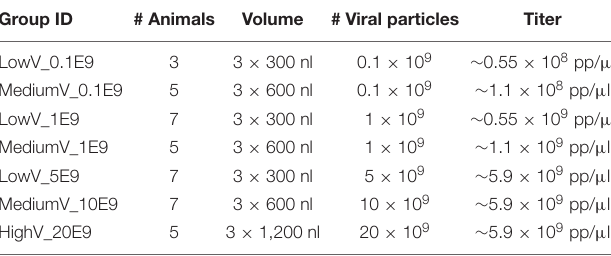
TABLE 1 | Overview of the different conditions: volume and number of physical viral particles. Group